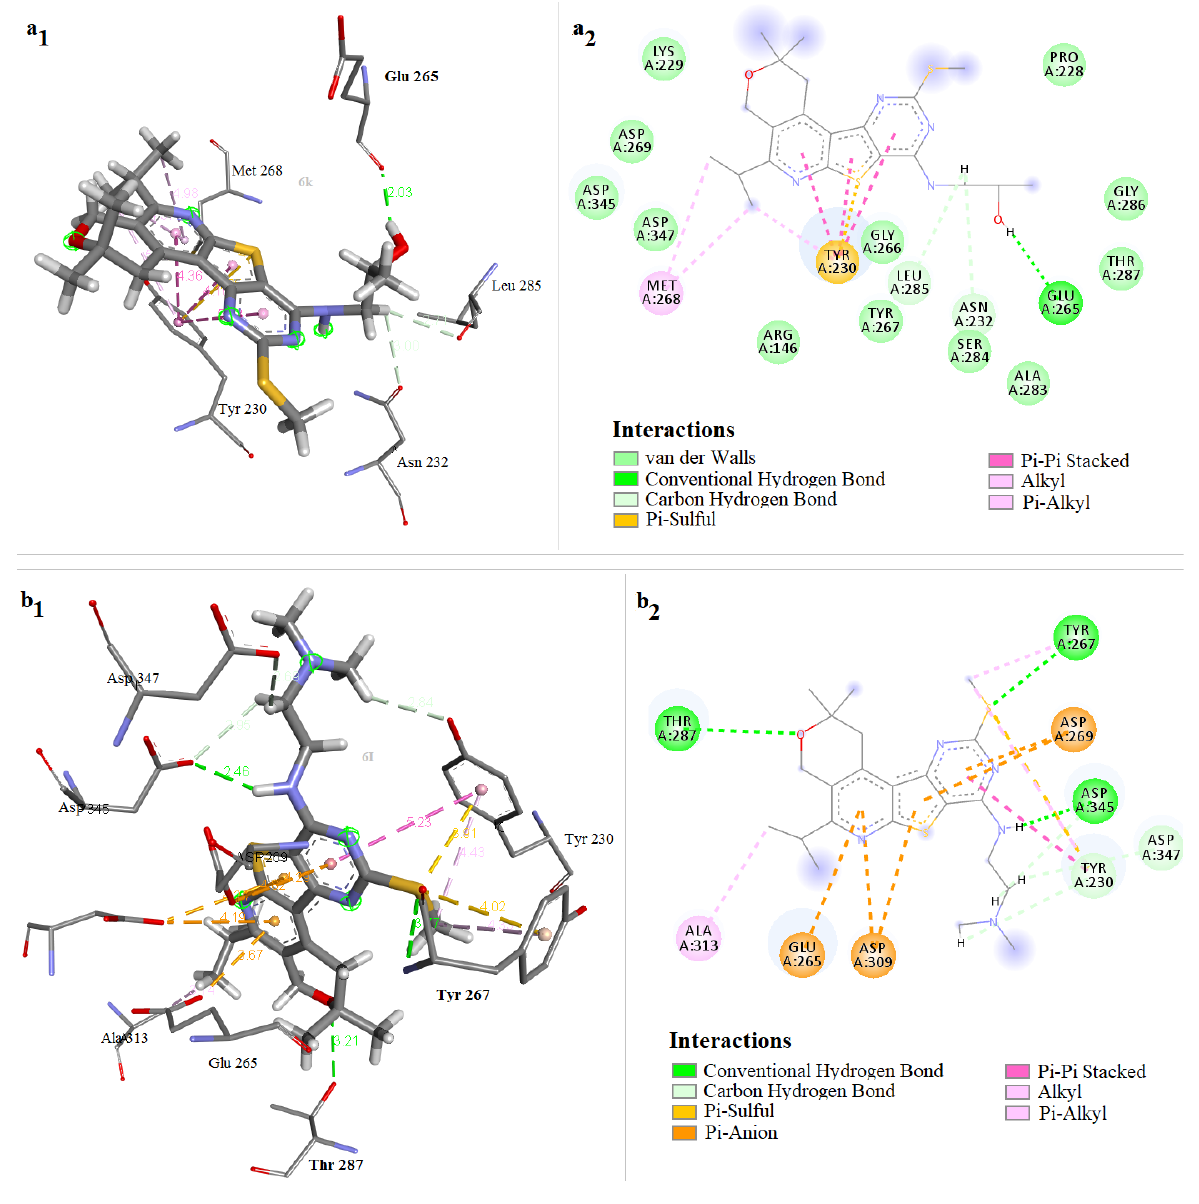
, a ) Docked conformation of the two most active compounds 6k and 6l ( b Figure 4 - ( a 1 2